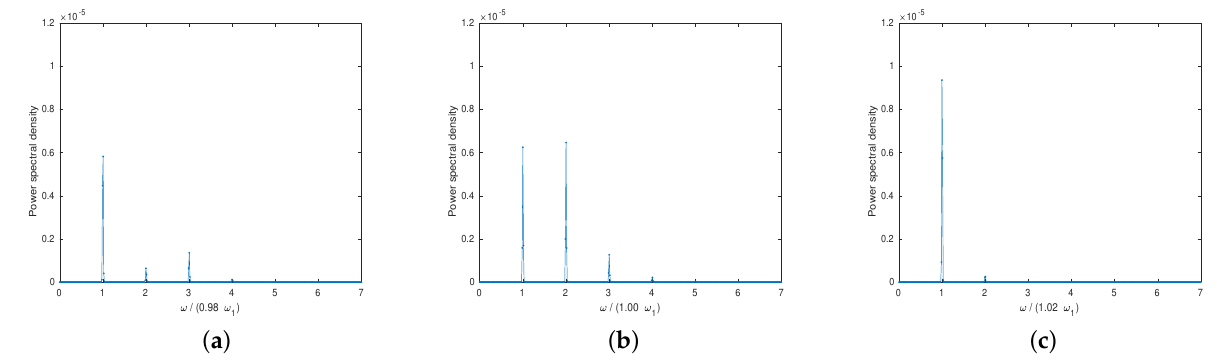
Figure 10. The frequency spectrum of coupled sway and roll cases under different excitation frequen- cies: ( a ) ω / ω 1 = 0.98; ( b ) ω / ω 1 = 1.0; ( c ) ω / ω 1 =